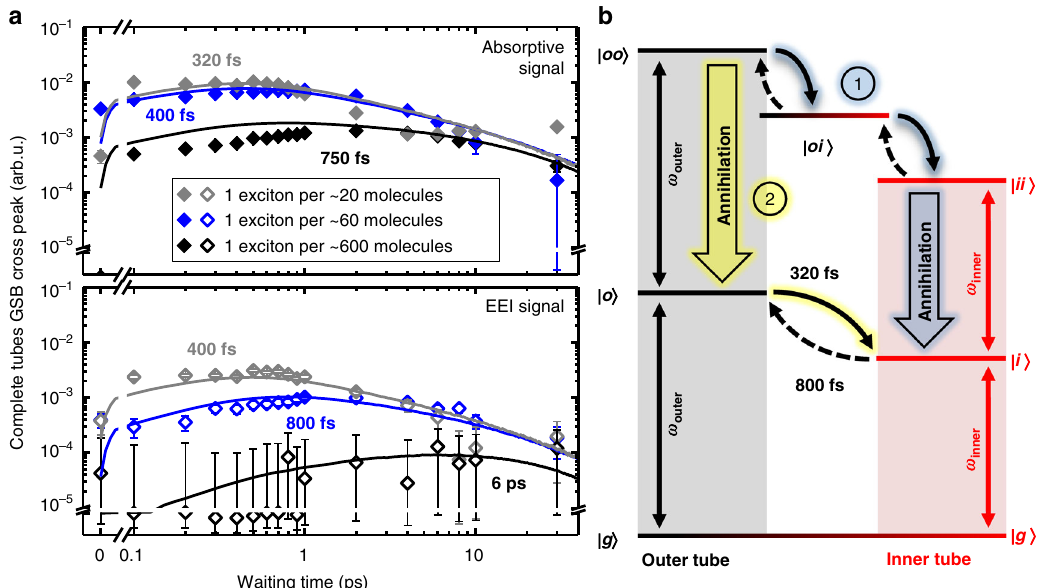
Fig. 5 Absorptive and EEI cross peak transients with corresponding level diagram. a Log – log plot of the absorptive (upper panel, solid diamonds) and EEI (lower panel, open diamonds) GSB/SE transients for the cross peak between outer and inner layer at different exciton densities. The transients were obtained by integrating the signal in the rectangular regions of interest shown in Fig. 2b. The absorptive cross peak maps ET from the outer to the inner tube ( ω outer → ω inner ), while the EEI cross-peak maps the subsequent occurrence of EEA and ET of two excitons from the outer tube (2 ω outer → ω inner ). The amplitude (vertical) scaling is identical to those in Figs. 3 and 4. The error bars refer to the detection noise level in the experiment (Supplementary Note 3). The solid lines depict the results from MC simulations of the exciton dynamics with parameters summarized in Table 1. For each fi tting curve the delay time at which the maximum signal occurs is explicitly stated. b Energy level diagram of the double-walled nanotubes illustrating bi-exciton (annihilation) pathways 1 (blue) and 2 (green) in presence of both tubes. Optical transitions of the inner and outer tube are marked by vertical arrows and their corresponding frequencies. Curved (dashed) solid arrows depict (thermally activated) ET pathways with their time constants